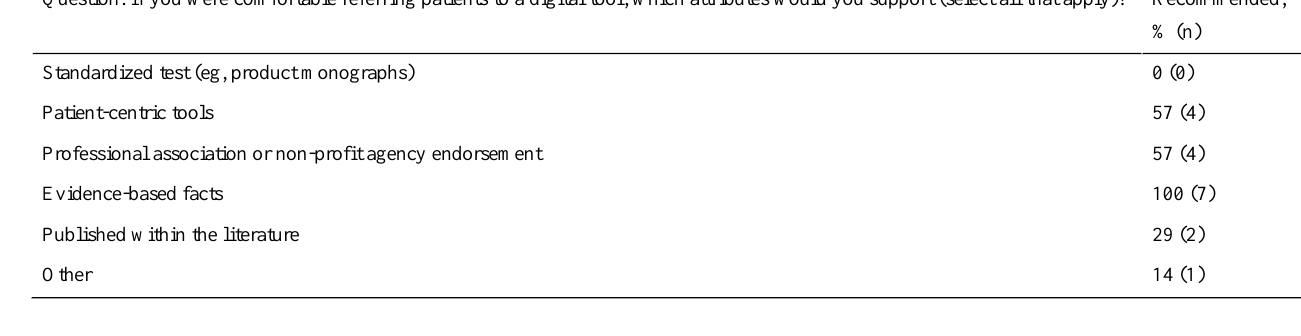
Table 3. Answers to research